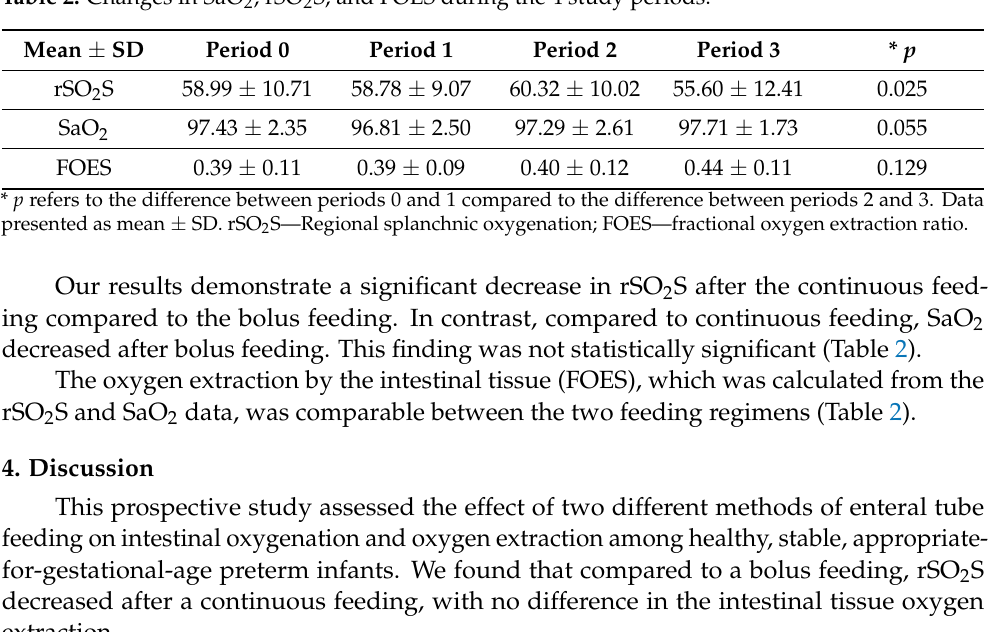
Table 2. Changes in SaO 2 , rSO 2 S, and FOES during the 4 study